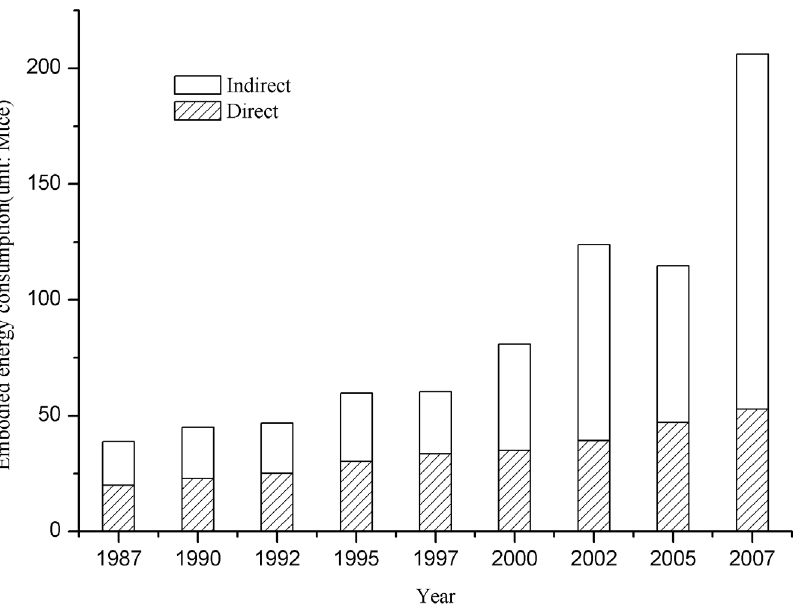
Figure 1. Embodied energy consumption of Beijing city from 1987 to 2007.